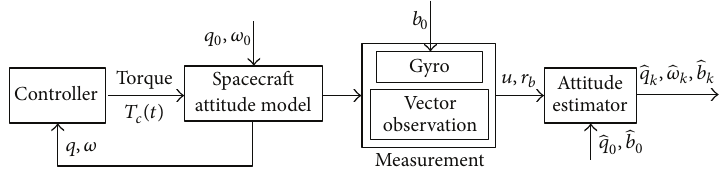
Figure 3: The diagrammatic representation of the attitude estimation system.